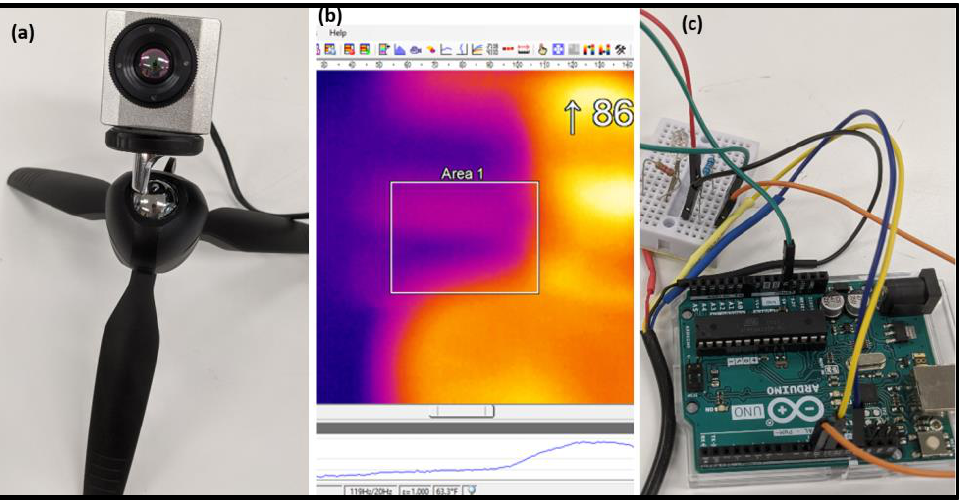
Figure 3. ( a ) Optrix PI 160 infrared camera, ( b ) Optrix PI Connect software and ( c ) temperature and Figure 3. (a) Optrix PI 160 infrared camera, (b) Optrix PI Connect software and (c) temperature humidity sensor and Arduino uno and humidity sensor and Arduino uno connection.